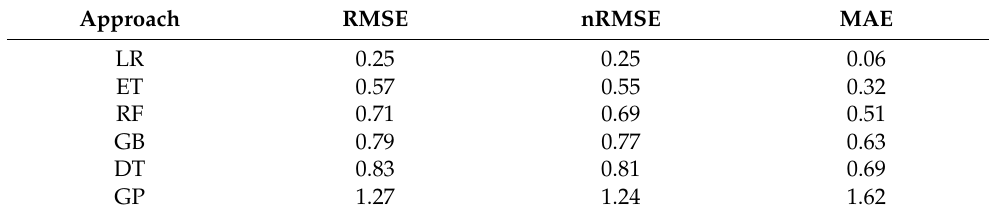
Table 2. Root-mean squared errors (RMSE), normalized root-mean squared errors (nRMSE), mean absolute errors (MAE), and Pearson correlation coefficients R 2 for the individual models regarding the test data between predicted C pred and observed values C Exp for the chemical reaction unit operation